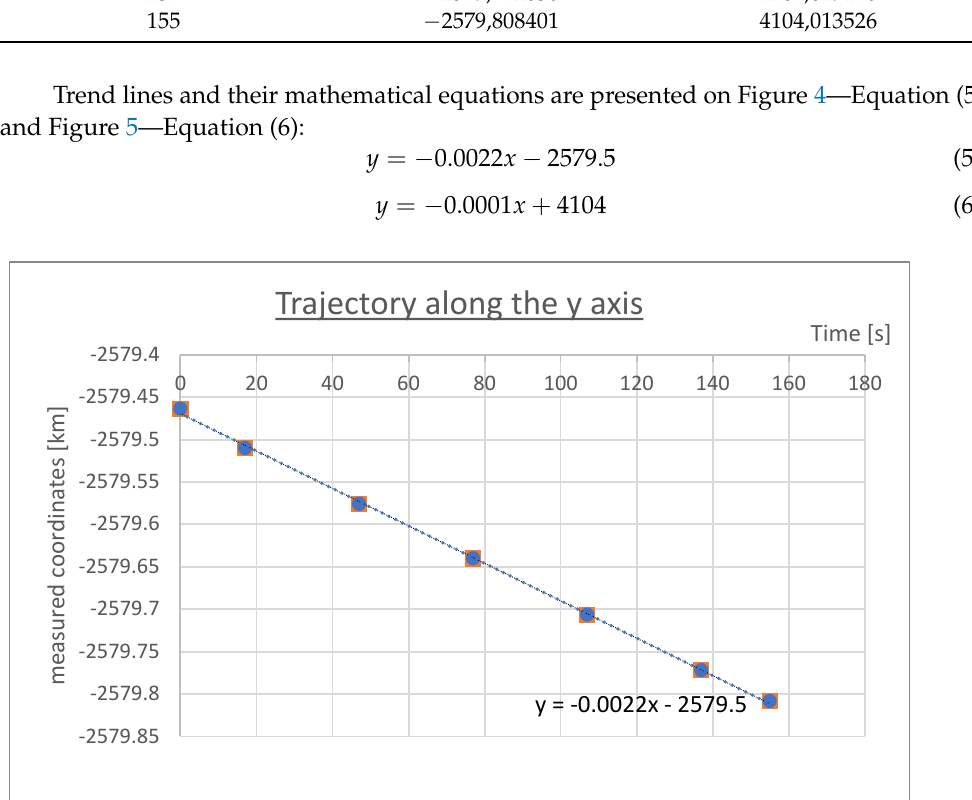
Table 1. x, y coordinates with assigned time.